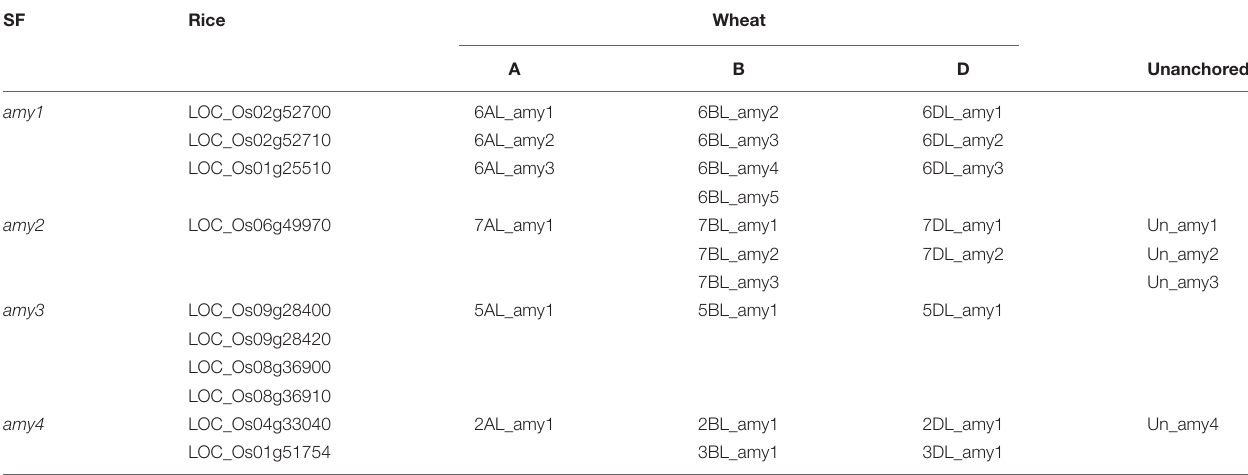
TABLE 2 | Orthologs of rice and wheat α -amylase